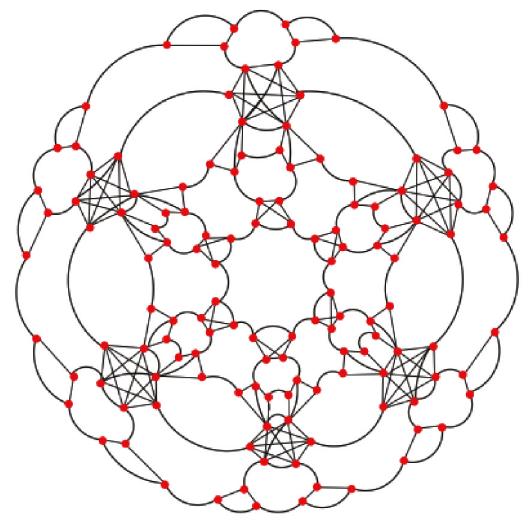
Figure 3: Line graph of the metal organic network with 2 layers or L ( MON ( 2 )) [48].